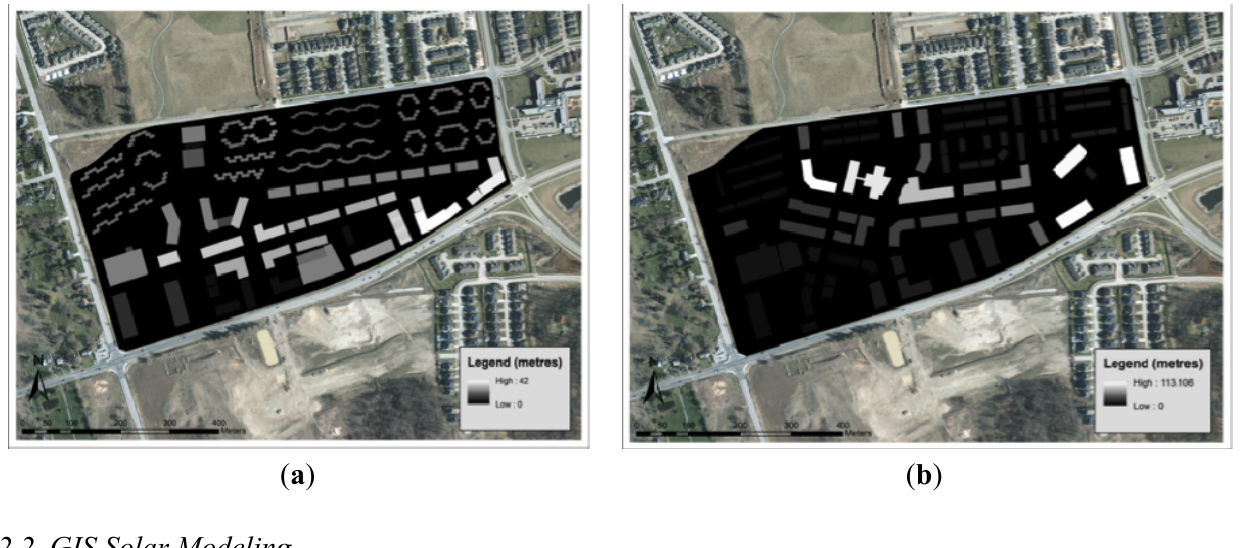
Figure 4. Converted 2D raster DEM at a resolution of 0.5 m converted from 3D file, projected onto orthophoto: ( a ) alternative community design and ( b ) original case study